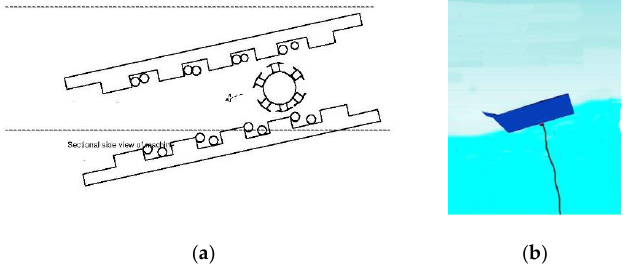
Figure 4. Step 2: The wave is leaving the converter via the tail: ( a ) cross-section view; ( b ) graphical representation.